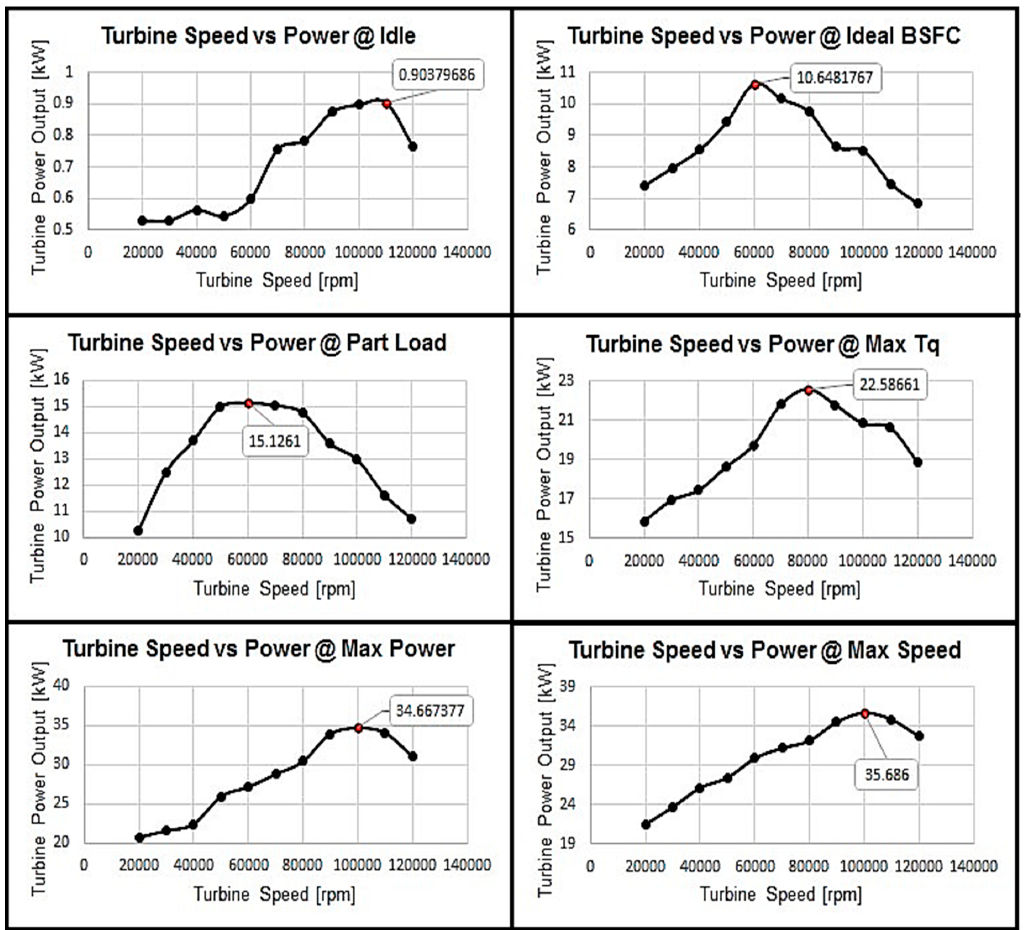
Figure 16. T/C system turbine power output in relation to turbine speed variation. Figure 16. T / C system turbine power output in relation to turbine speed